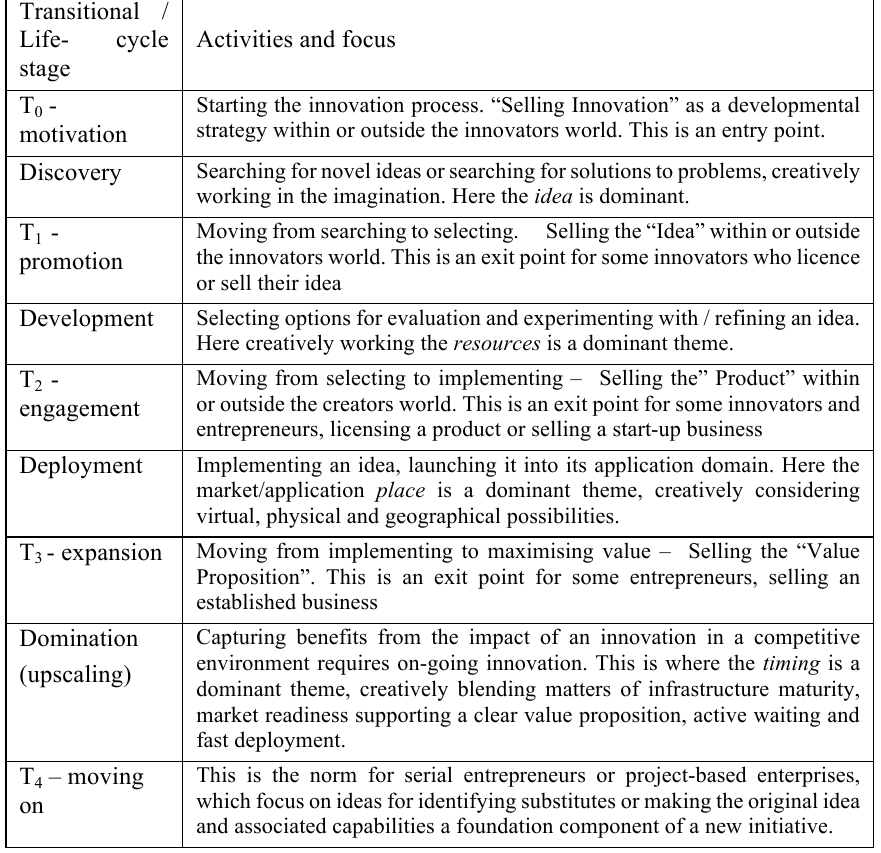
Table 2. Characteristic innovation project / innovative enterprise lifecycle